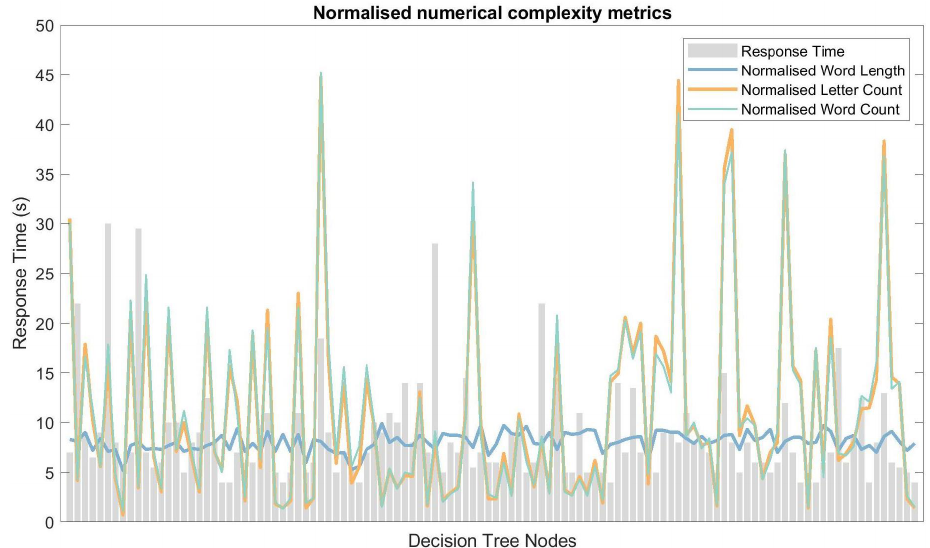
Figure 5. Normalised numerical complexity metrics and response times (vertical axis) of individual nodes (horizontal axis). The mean word length and median response times are shown. The central tendency metrics are selected based on the distribution of the data.